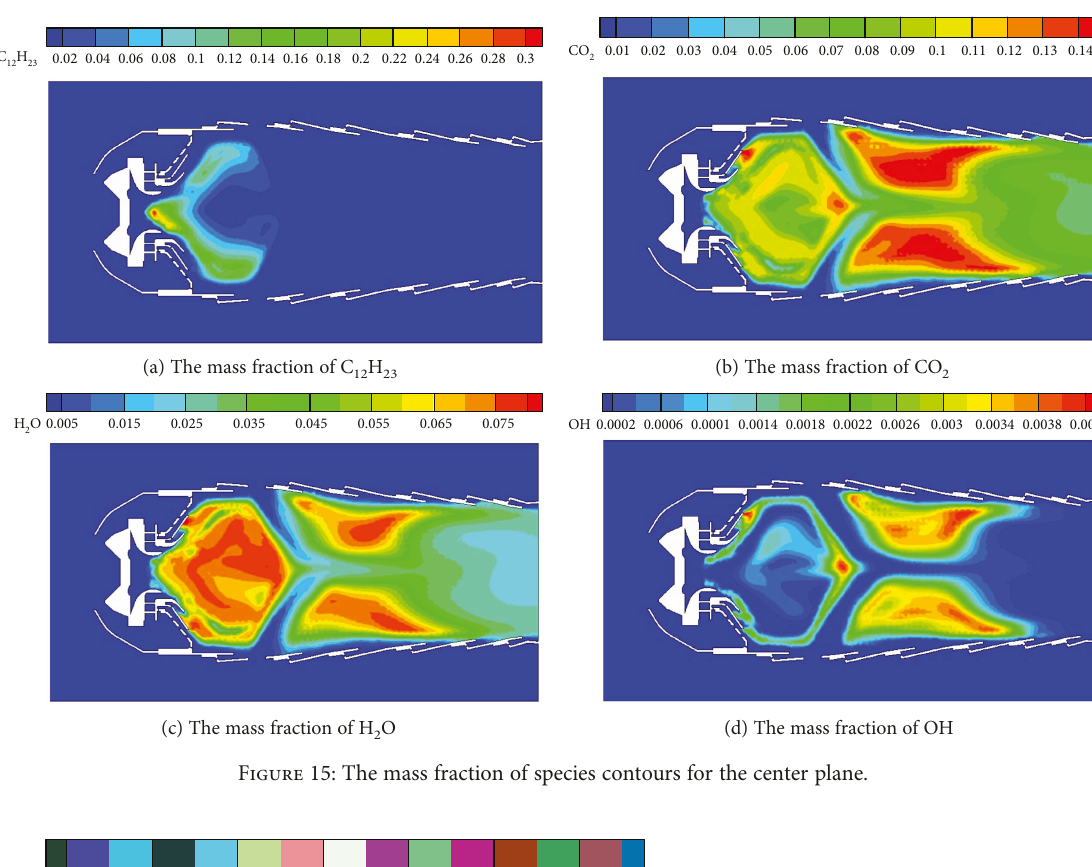
Figure 15: The mass fraction of species contours for the center plane.